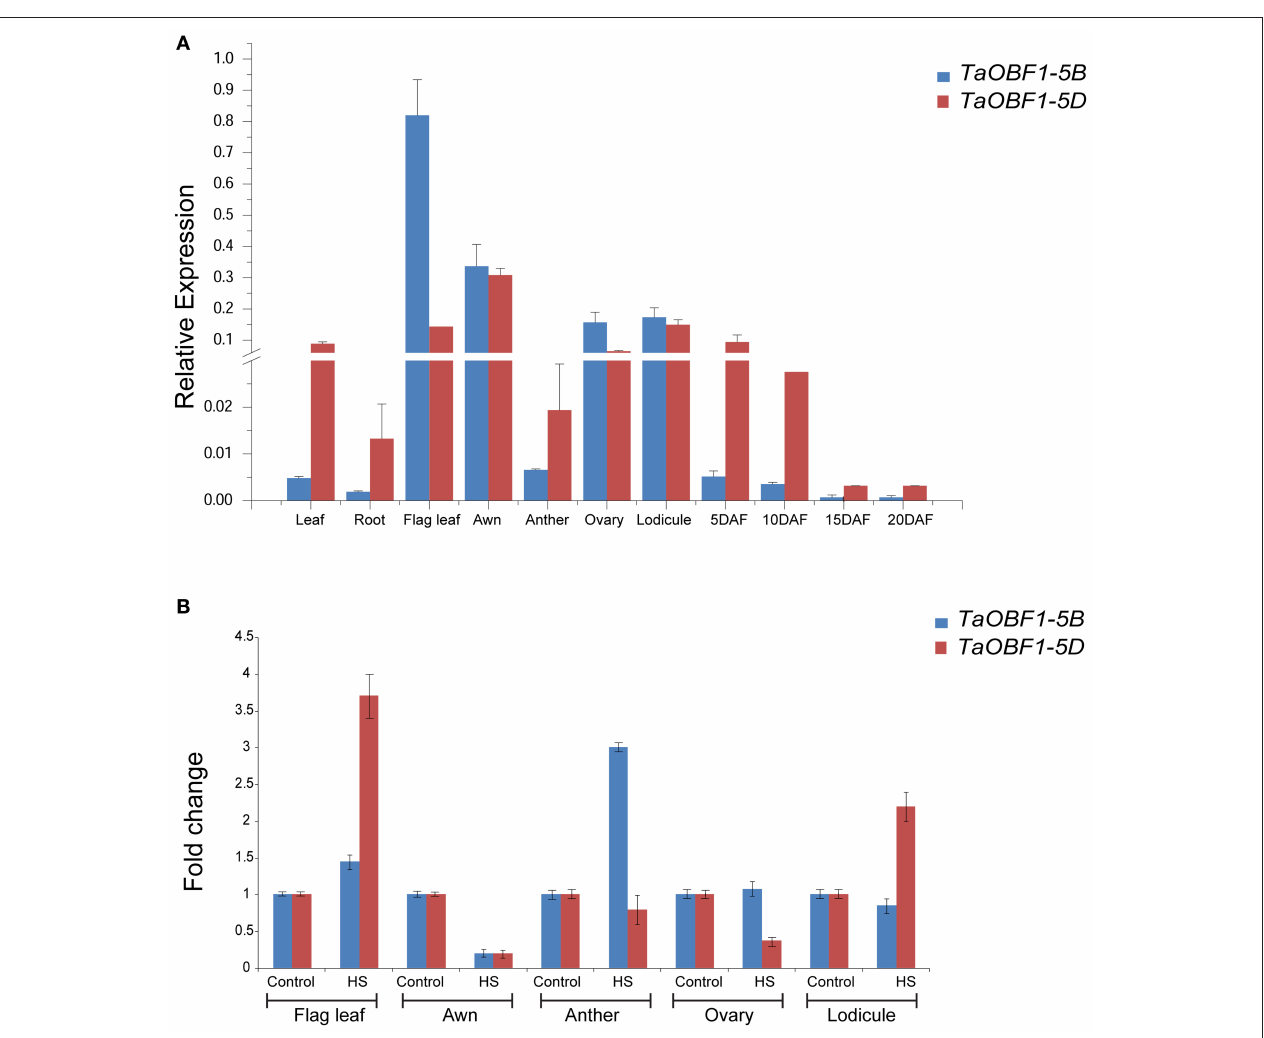
FIGURE 1 | Expression analysis of TaOBF1 homoeologs in different tissues of wheat cv. PBW343 seedlings under (A) control and (B) heat stress conditions. Relative expression was checked in different tissues by qRT-PCR. TaGAPDH was used as an internal control gene. Error bars indicate values ± SD. DAF, days after fertilization.